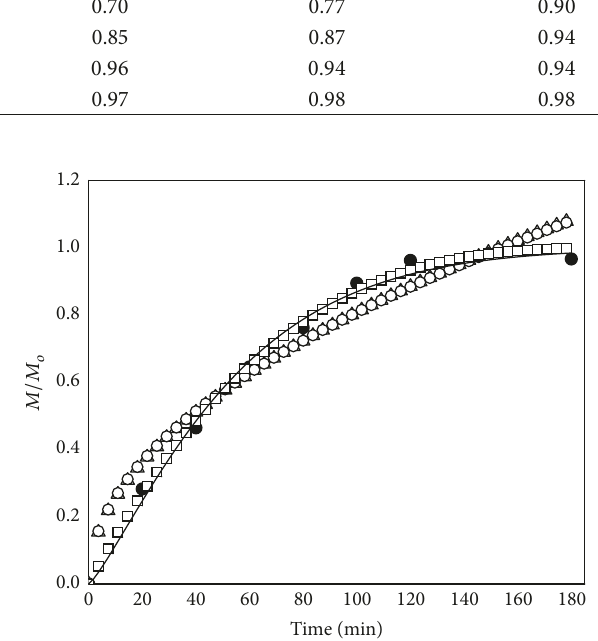
Figure 6: Curve fitting to the release of ibuprofen from nanopar- ticles prepared at F1/5/1 conditions: equations of ( △ ) Higuchi, ( I ) Korsmeyer-Peppas, and ( ◻ ) Hixson; the line represents Weibull equation and ( e ) the experimental